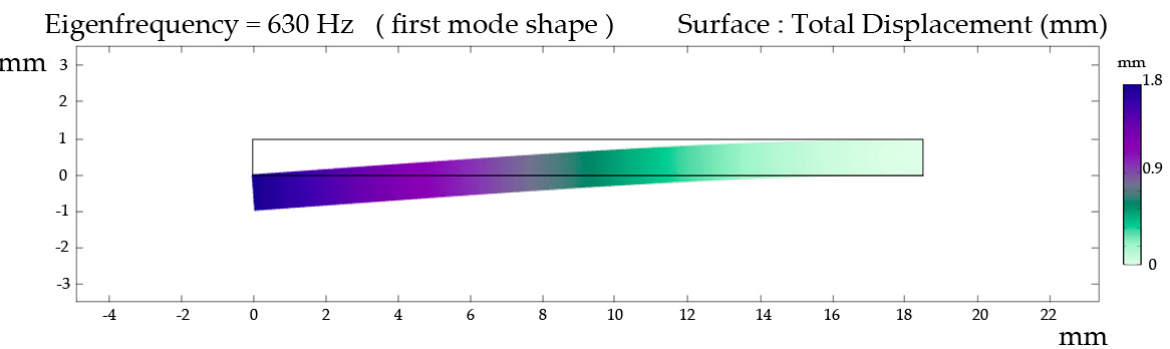
Figure 13. Output voltage from piezoelectric beam I at first mode shape. 3.4.3. Simulation Based on Piezoelectric Beam II The second piezoelectric beam, 46 mm long and 0.99 mm thick, experiences a reso- nance phenomenon at the second mode shape (Figure 14). The output voltage at the fre- quency of 630 Hz is equal to 1.52 mV. Figure 15 shows the output voltage versus frequency for this beam. Figure 14. Second mode shape of piezoelectric beam II.